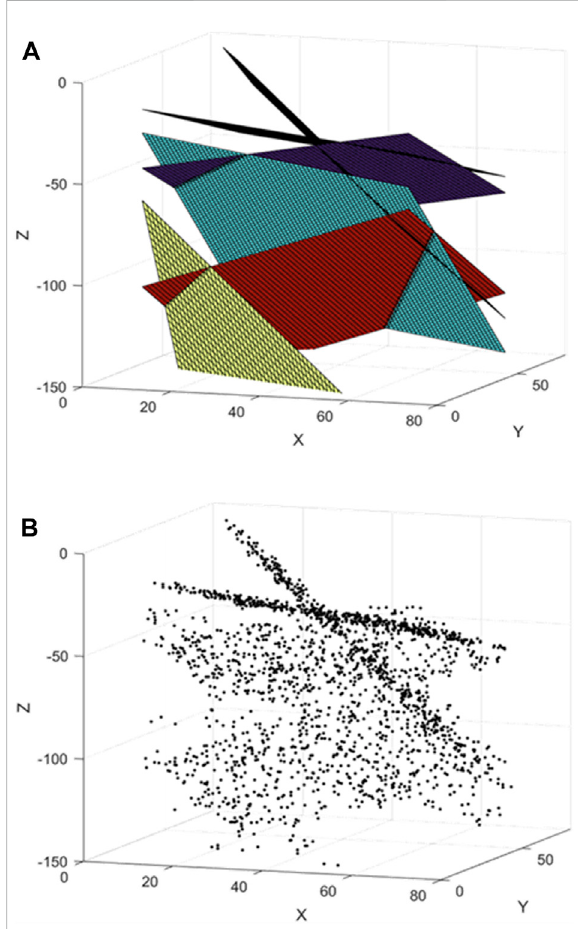
FIGURE 3 Synthetic experiments to verify the effect of orientation on fracture plane extraction. (A) True model consisting of six fracture planes and (B) 200 randomly distributed points from each fracture plane with low ratios of location